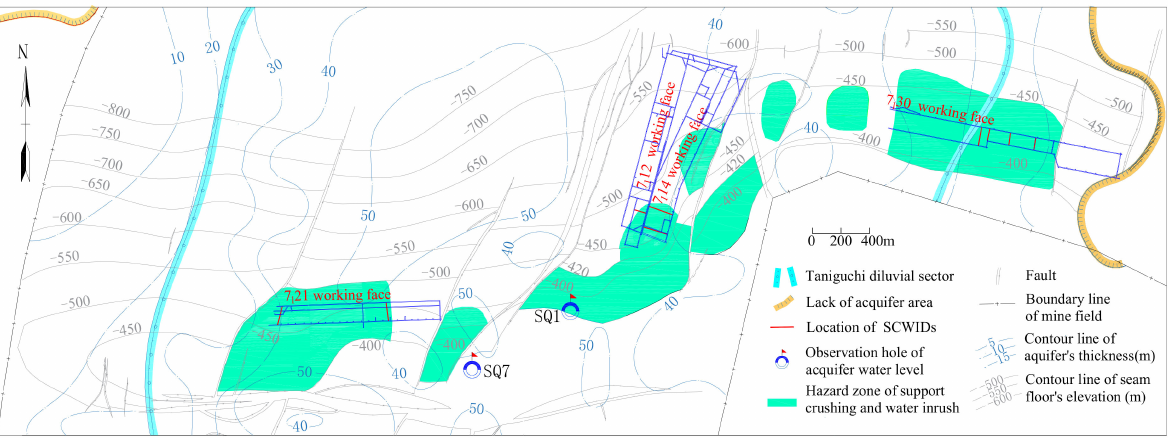
Figure 11. Prediction of dangerous area of SCWID at No.7 1 coal seam in Qidong coal